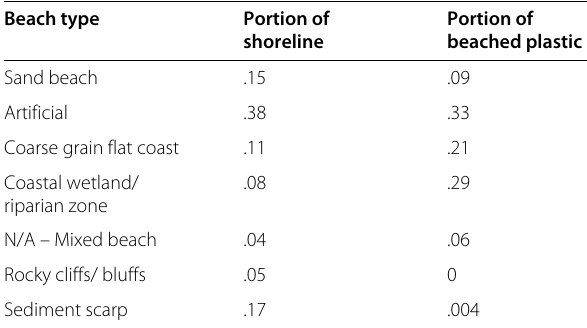
in the Cleveland region when weighted by population.